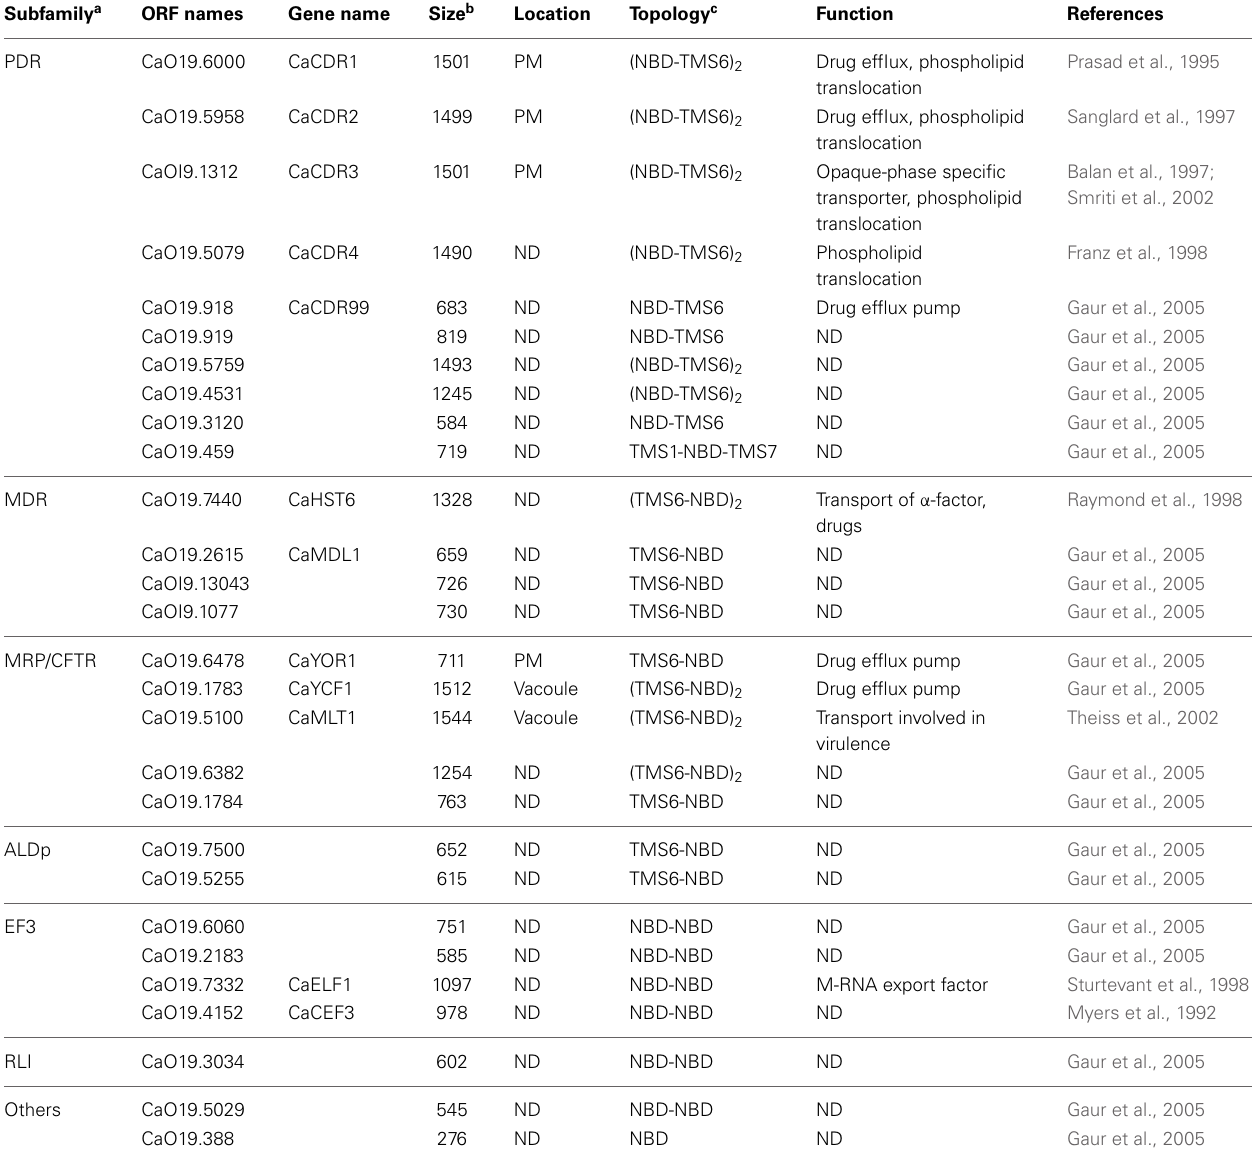
Table 1 | ABC transporters of Candida albicans